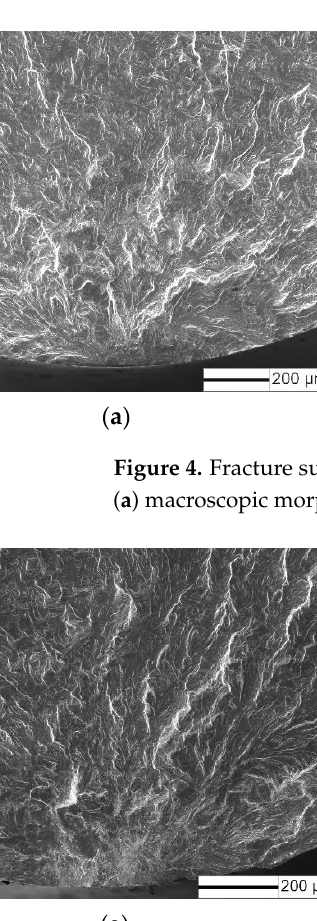
Figure 3. Fracture surface for 0.5% predamage specimens at σ = 450 MPa and N = 3.44 × 10 7 cycles: ( a ) macroscopic morphology, and ( b ) crack initiation morphology.